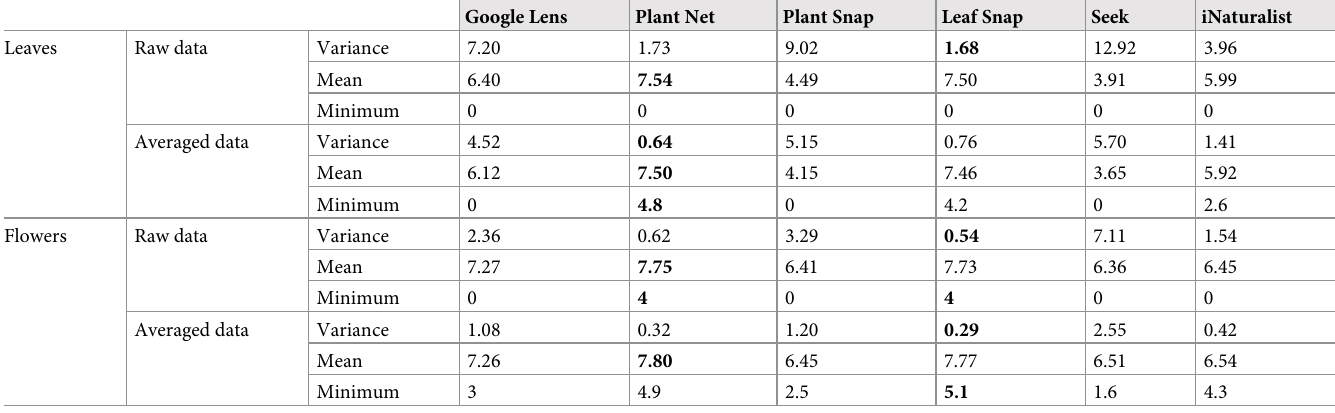
than Plant Snap and iNaturalist (p > 0.75). Plant Snap and iNaturalist did not show a signifi- cant difference in flower identification scores when the score was averaged per species (p = 1). Table 3 shows key descriptive statistics for the leaf and flower analysis of both raw and averaged data for each app. Plant Net and Leaf Snap recorded the lowest variance, the highest mean score and the highest minimum score for leaf and flower raw data and averaged data. Seek and Plant Snap recorded the lowest mean score and the highest variance for leaf and flow- ers in the raw data, and the averaged data. All apps achieved a maximum score of 8 for some species and so this is not shown in the table. Plant Net and Leaf Snap scored the highest mini- mum score in the raw flower dataset. The minimum scored achieved by all apps in the raw leaf Table 3. Key descriptive statistics recorded for both raw and averaged data for both the leaf and flower datasets.